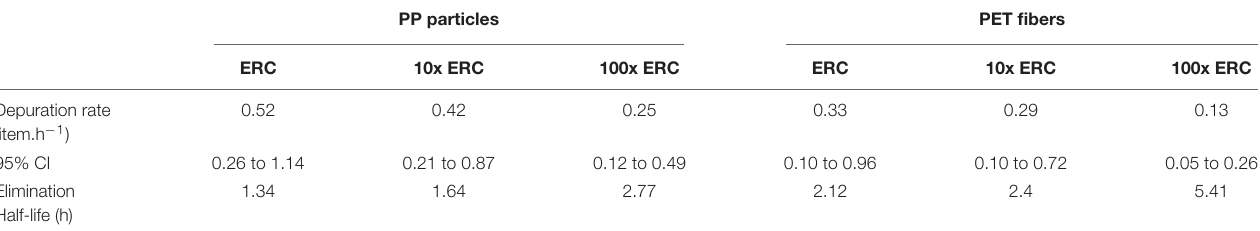
TABLE 6 | Microplastics depuration rate (in items h − 1 ) with 95% confidence interval (CI), and elimination half-life (h) of polypropylene (PP) particles, and polyester (PET) fibers in three treatment groups ( n = 84 tanks) following a single exposure of adult damselfish Pomacentrus amboinensis in a controlled laboratory experiment.